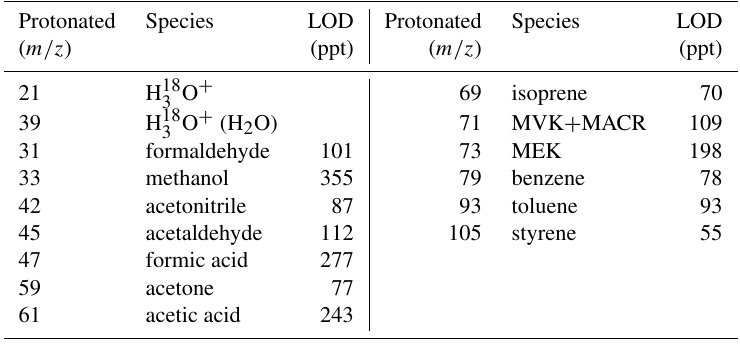
Table 1. List of reported VOC species along with their protonated m/z , and 5min limits of detection (LODs). Protonated Species LOD Protonated Species